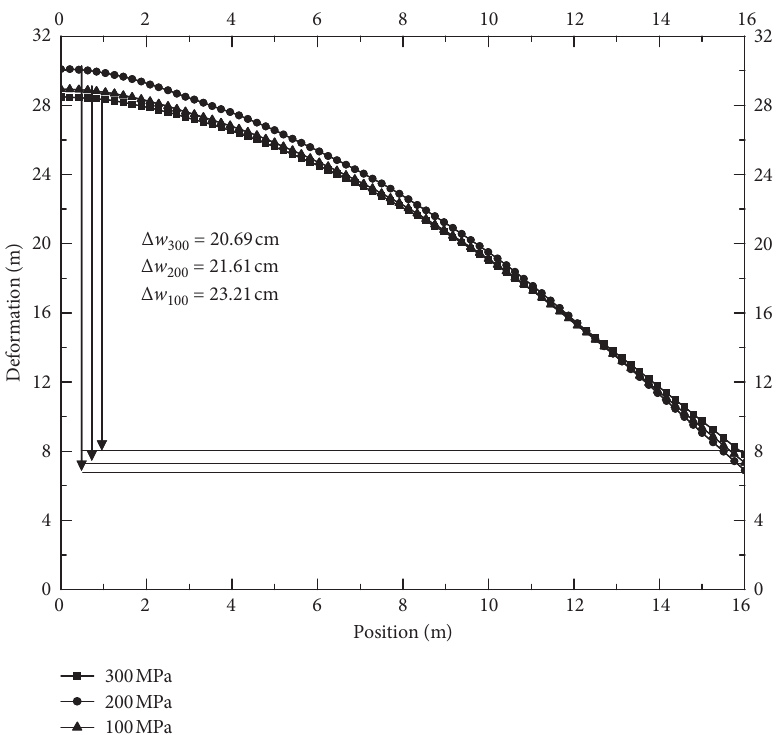
Figure 14: Deformation versus time with different elastic modulus of